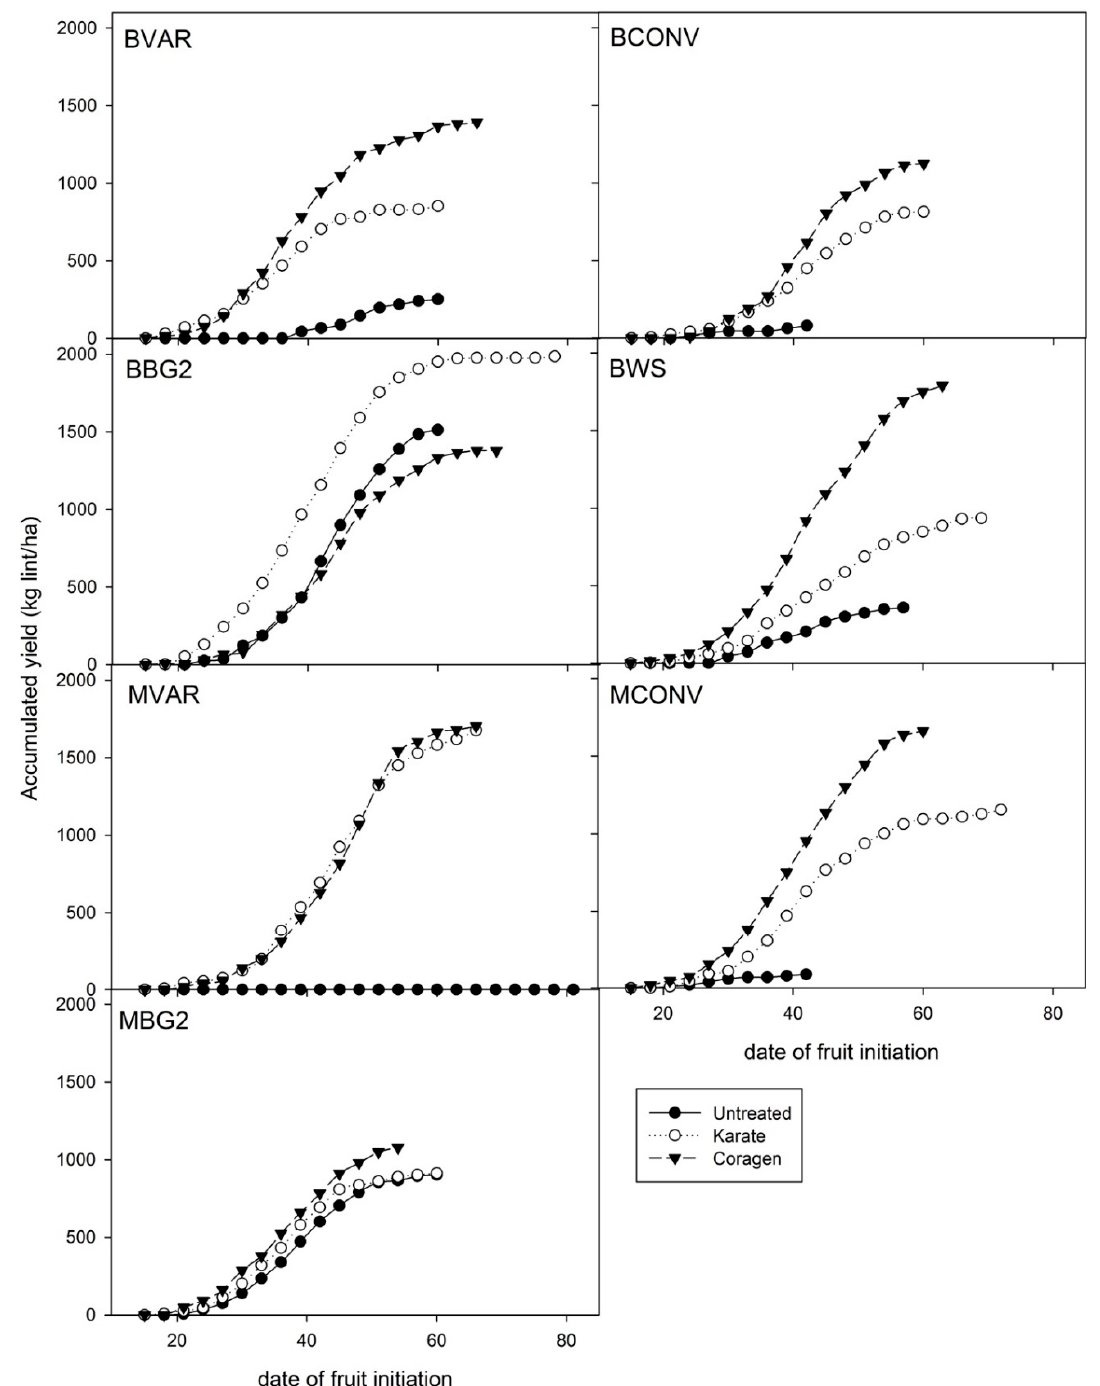
Figure 4. Cumulative yield (kg lint/ha) versus date of fruit initiation in 2011 studies. Table 9. Mean days after planting ± SEM of fruit initiation per surviving fruit and g of lint ± SEM harvested in 2011 box maps. Means not followed by a common letter indicate significant differences between treatments based on LSD at p < 0.05